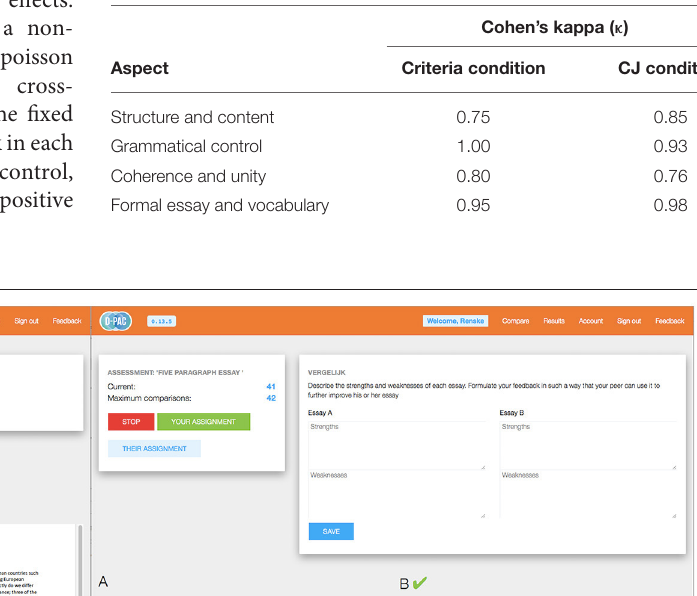
TABLE 1 | Interrater Agreement for Peer Feedback Coding in the Criteria and CJ Condition.